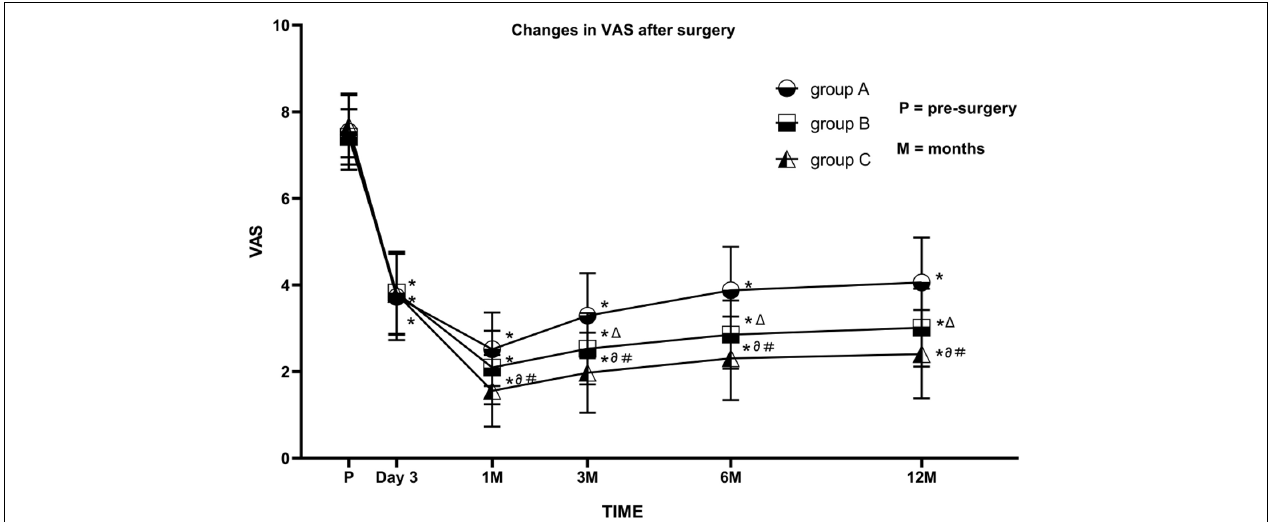
FIGURE 3 | Comparison of visual analog scale (VAS) scores before and after PRF in the three groups. Group A (45 V PRF); Group B (55 V PRF); Group C (65 V PRF). Results are presented as mean ± SD. Compared to pre-surgery VAS, * P < 0.05; group B compared to group A, (cid:49) P < 0.05; group C compared to group A, ∂ P < 0.05; group C compared to group B, # P < 0.05.